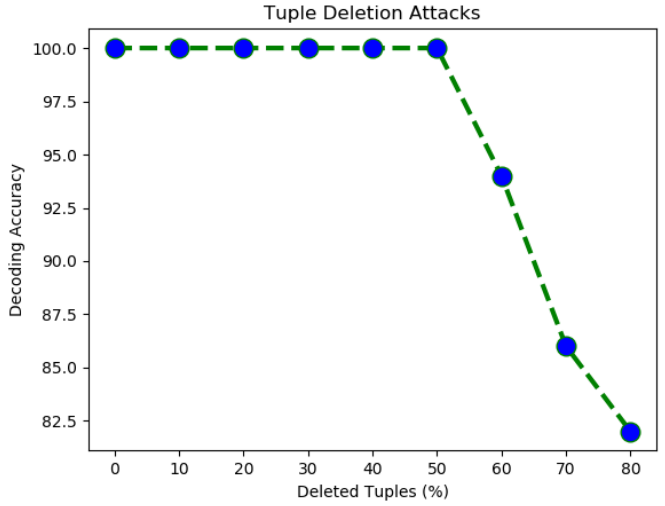
Figure 3. Robustness against tuple deletion